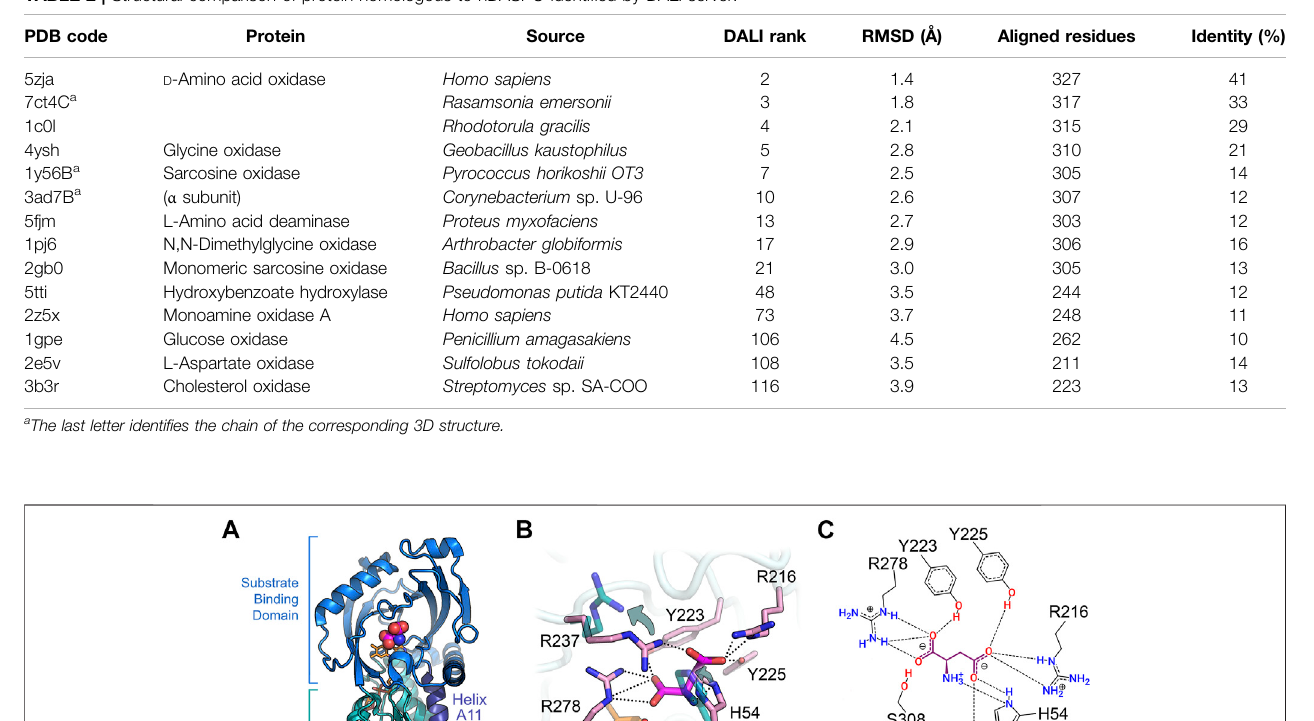
TABLE 2 | Structural comparison of protein homologous to hDASPO identi fi ed by DALI server. PDB code